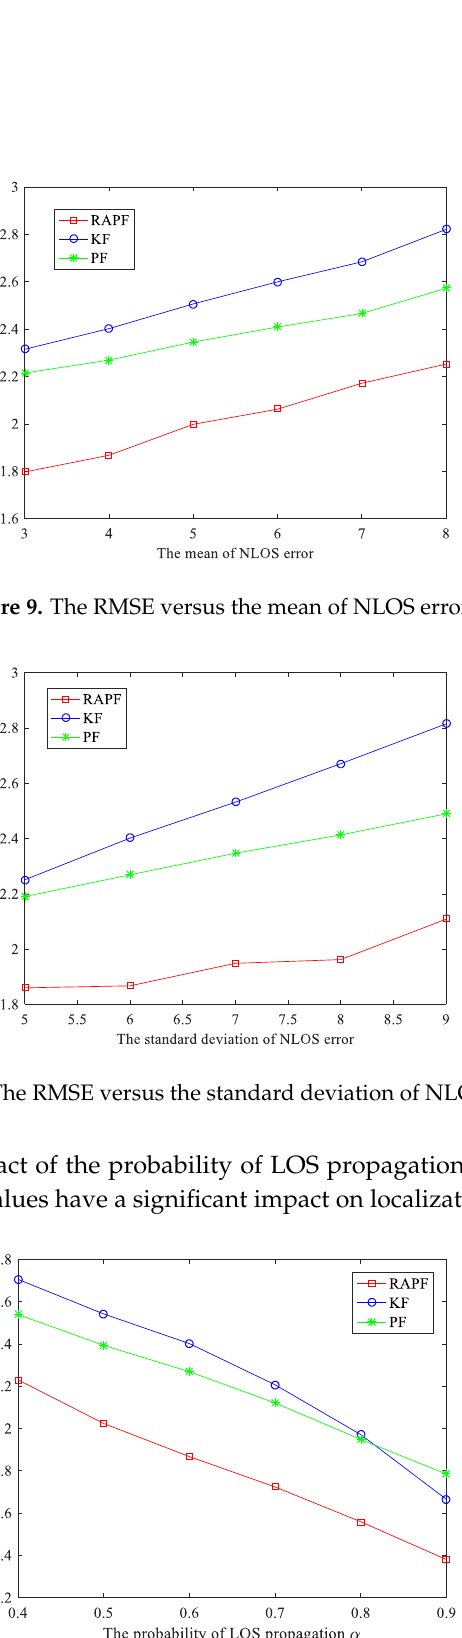
Figure 11. The RMSE versus the probability of LOS propagation α